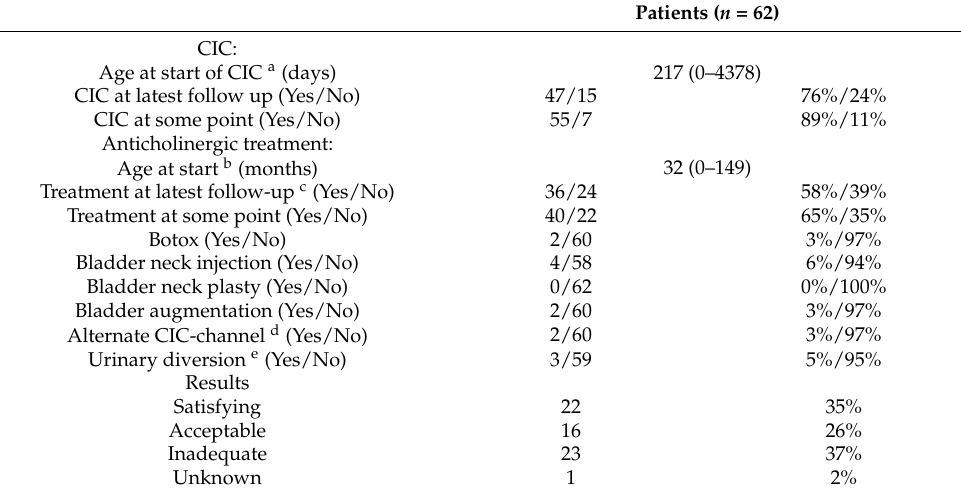
Table 2. Bladder management in 62 patients with spina